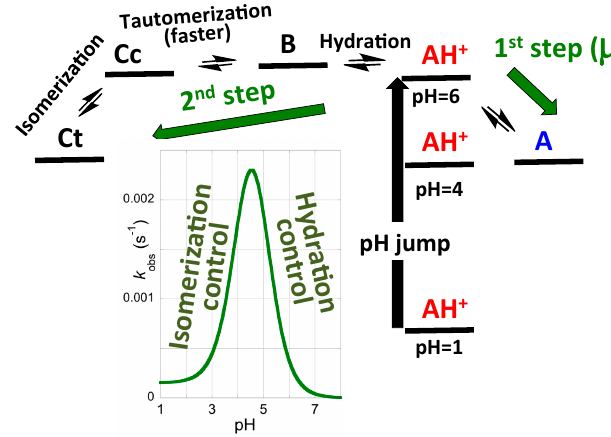
Scheme 8. Energy level diagram of compound 2 .